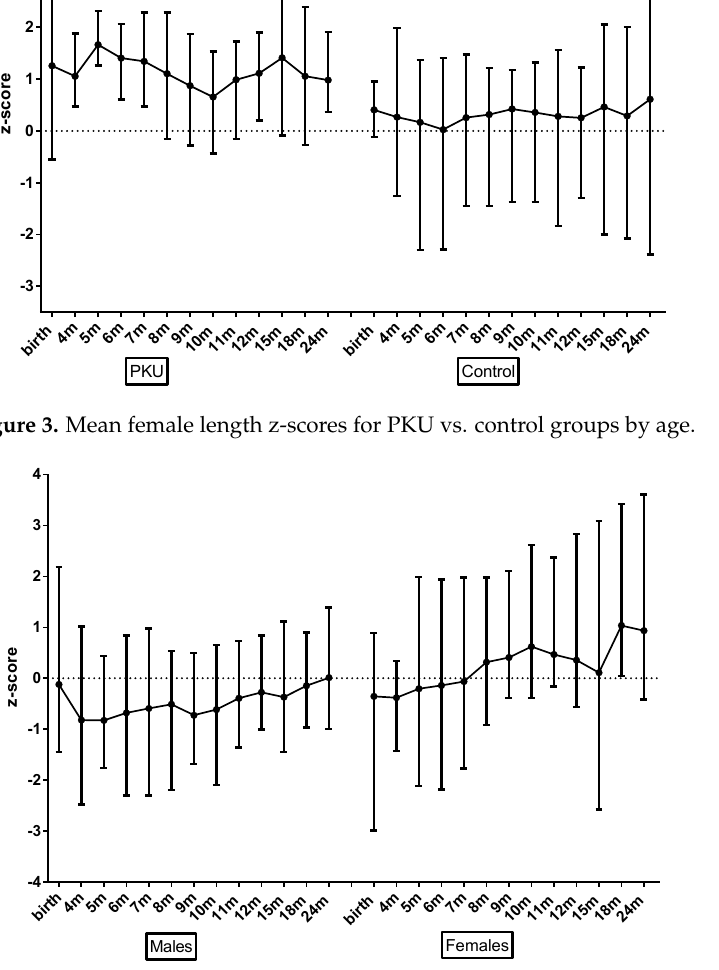
Figure 4. Mean PKU BMI z-scores for male vs. female by